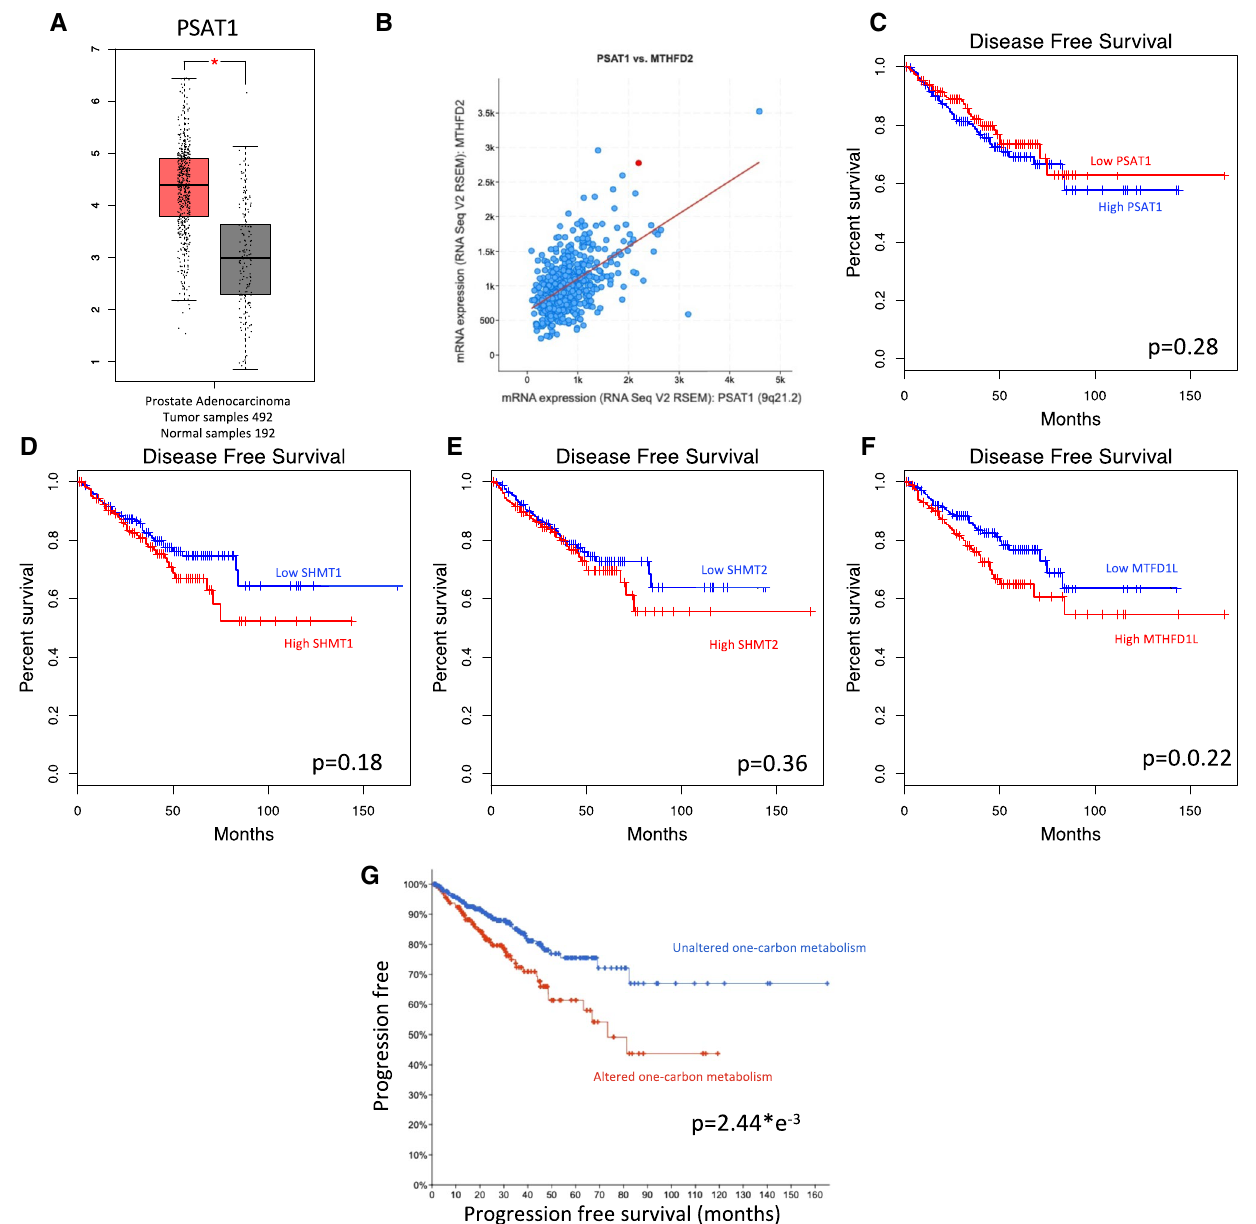
Fig. 4 One-carbon metabolism enzymes clinical correlations. A PSAT1 log scale differential gene expression between prostate cancer tis- sues compared to normal matching controls (GEPIA), p-value is calculated applying the one-way ANOVA statistical method; B mRNA expres- sion correlation of PSAT1 and MTHFD2 enzymes in prostate cancer tissues, Spearman coefficient 0.48 (p < 0.001, two-sided T-test) Pearson coefficient 0.54 (p < 0.001, two-sided T-test); C – F disease-free survival Kaplan–Meier plots stratifying patients according to expression levels of PSAT1 ( C ), SHMT1 ( D ), SHMT2 ( E ) and MTHFD1 ( F ) (GEPIA), p-values are calculated applying the log-rank test; G cumulative one-carbon metabolism alterations and progression-free survival of prostate cancer patients from TCGA (cBioportal), p-values calculated using